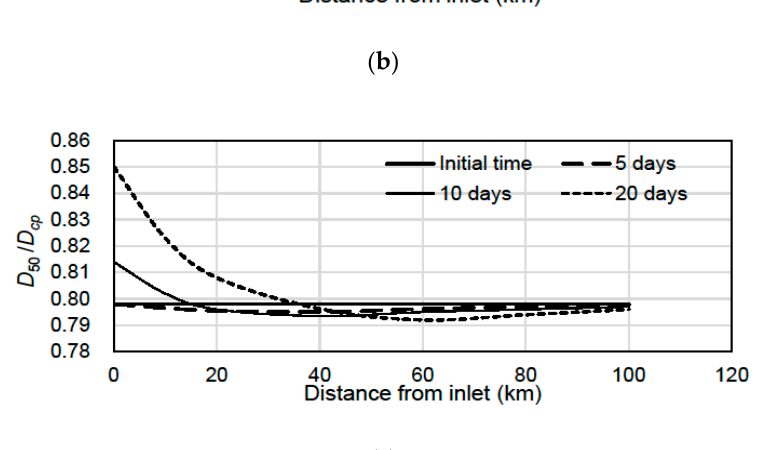
Figure 5. Spatial variation in the bed material under erosion conditions. ( a ) D cp ; ( b ) D 50 ; and ( c ) D 50 / D cp .